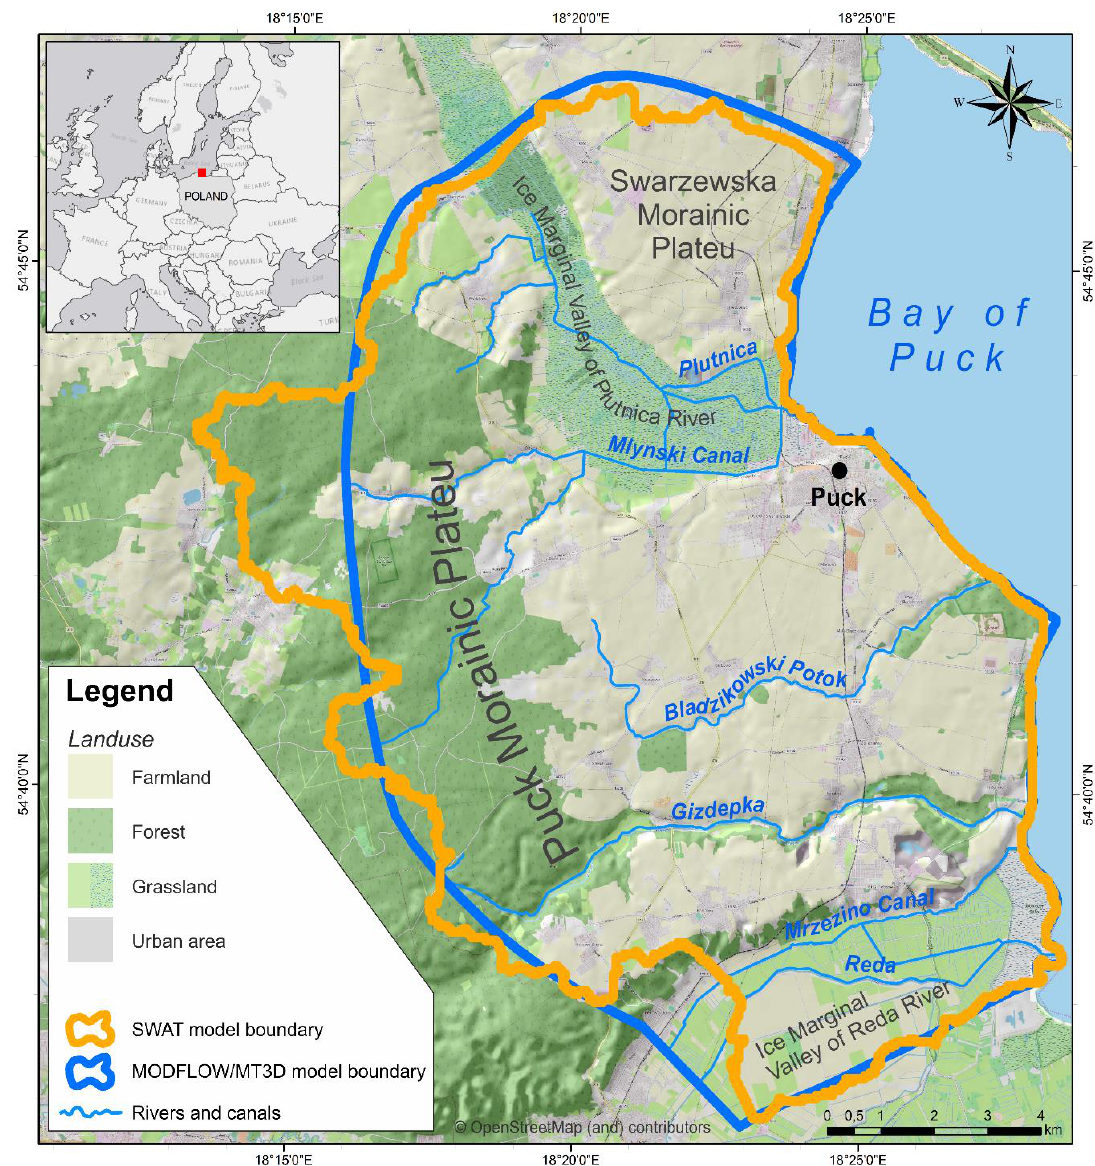
Figure 1. Map of land use in the study area with boundaries of SWAT and MODFLOW / MT3D models.